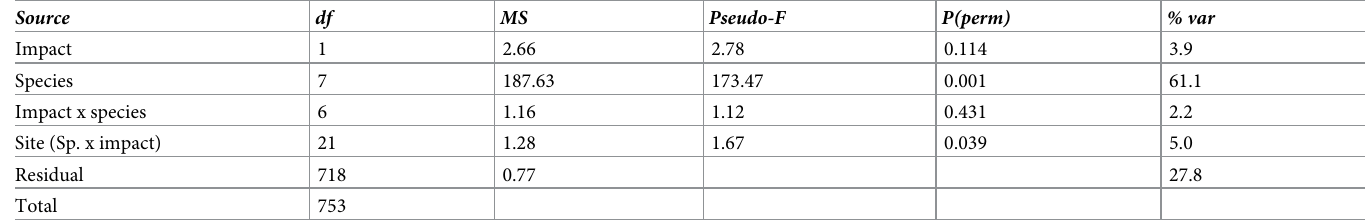
Table 5. Results of PERMANOVA analysis testing for the effects of human impact on the Mg content in calcite, with tests for each species (impact x species). PER- MANOVA was done on untransformed skeletal Mg-calcite using a Euclidean distance similarity matrix. % var = Estimates of components of variation of Mg content in